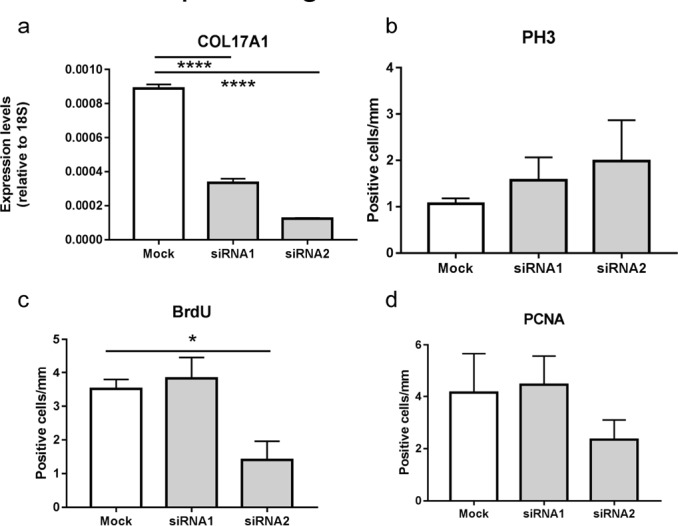
Proliferative ability of 3D reconstituted human epidermis treated with COL17A1 siRNAsDOI: